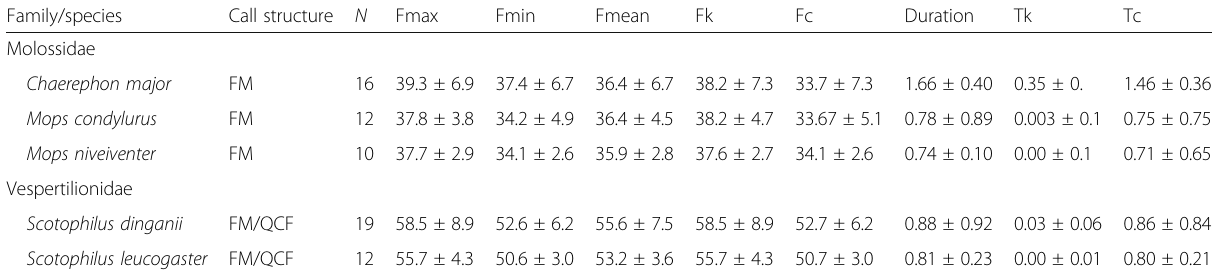
Table 2 Descriptive statistics for echolocation parameters of five species of insectivorous bats in the Far North region of Cameroon